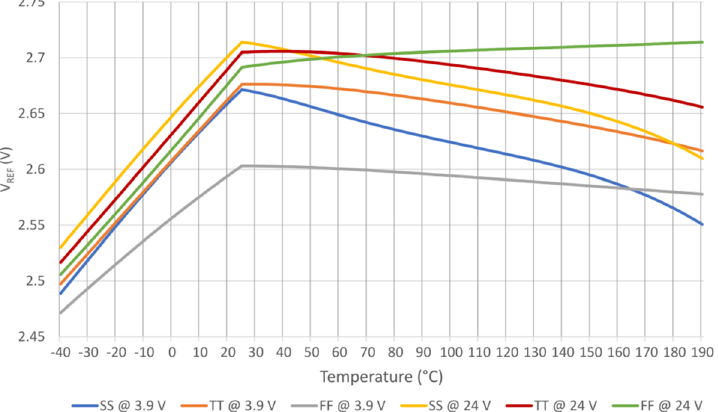
Figure 8. Corner analysis of reference voltage in the temperature range from −40°C to 190°C for two supply values (3.9 V and 24 V).